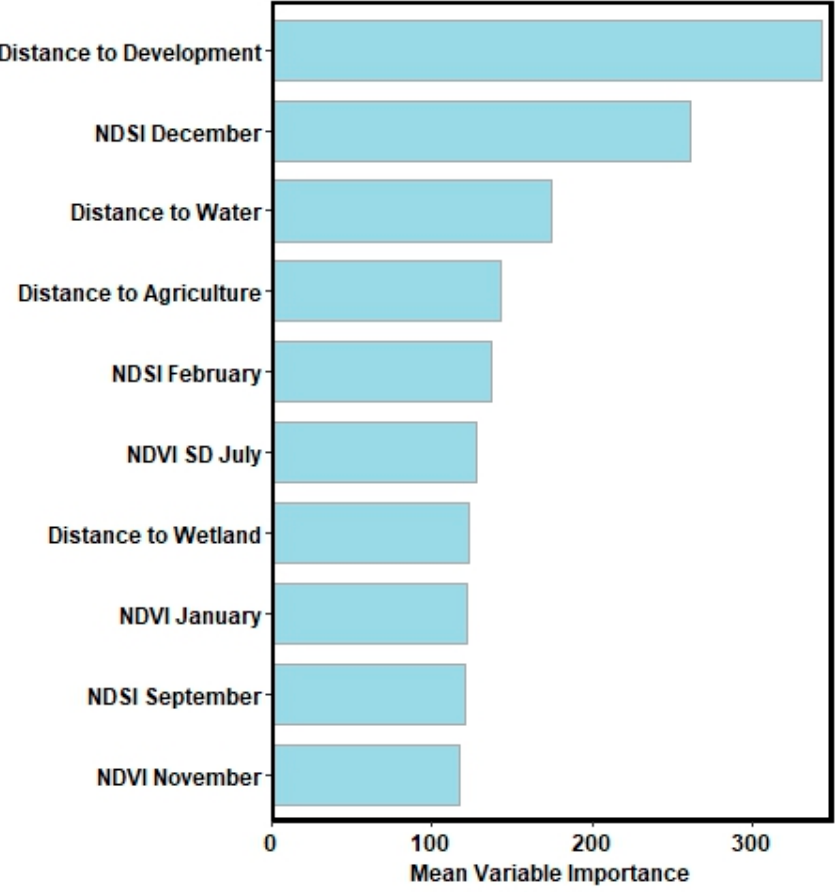
Figure 3. Variable importance by permutation accuracy. The random forest model assesses the importance of every variable used in the model. A larger mean variable importance (x-axis) gives evidence of a larger contribution of that individual variable in correctly discriminating the habitat type. Here, only the top ten most important variables are shown: distance to development, snow cover (NDSI) in December, distance to water, distance to agriculture, snow cover (NDSI) in February, standard deviation in vegetation (NDVI SD) in July, distance to wetlands, vegetation cover (NDVI) in January, snow cover (NDSI) in September, and vegetation cover (NDVI) in November.